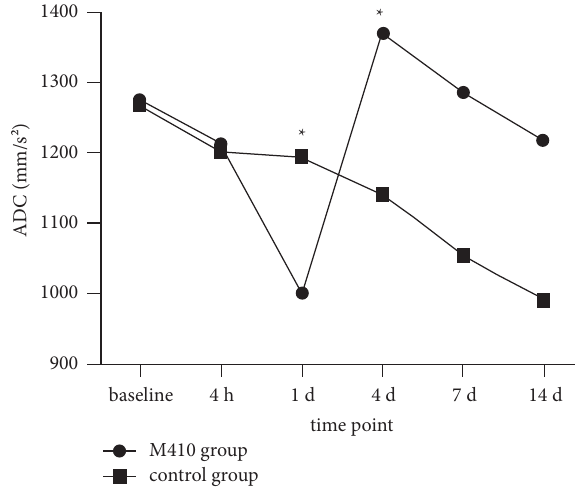
Figure 4: Changes in the mean apparent diffusion coefficient (ADC) from the solid component of the tumor of two groups at different time points. The mean ADC values of the M410 group of tumor parenchyma decreased from the baseline to d 1, then in- creased until d4, and decreased again until d 14. The control group values fell continuously from the baseline to d14. There was a statistically significant difference in the mean ADC values of the entire tumor between the two groups at the time points of d 1 and d 4 ( P � 0 . 04 ,P � 0 .